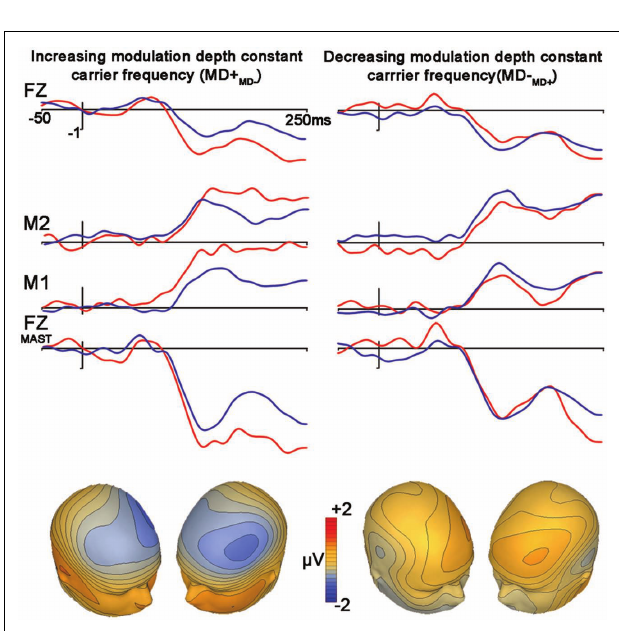
FIGURE 4 | Control condition. Differences in modulation depths. Figure legend follows that of Figure 2 .